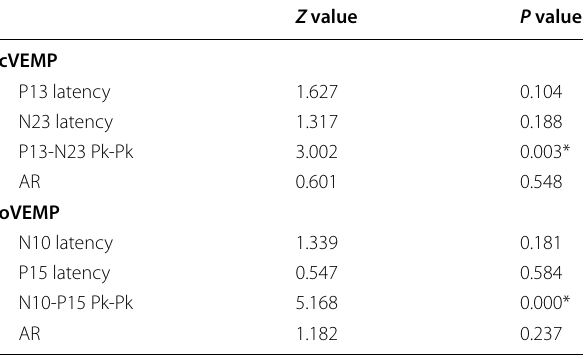
Table 2 Mann-Whitney U test results for the cVEMP and oVEMP